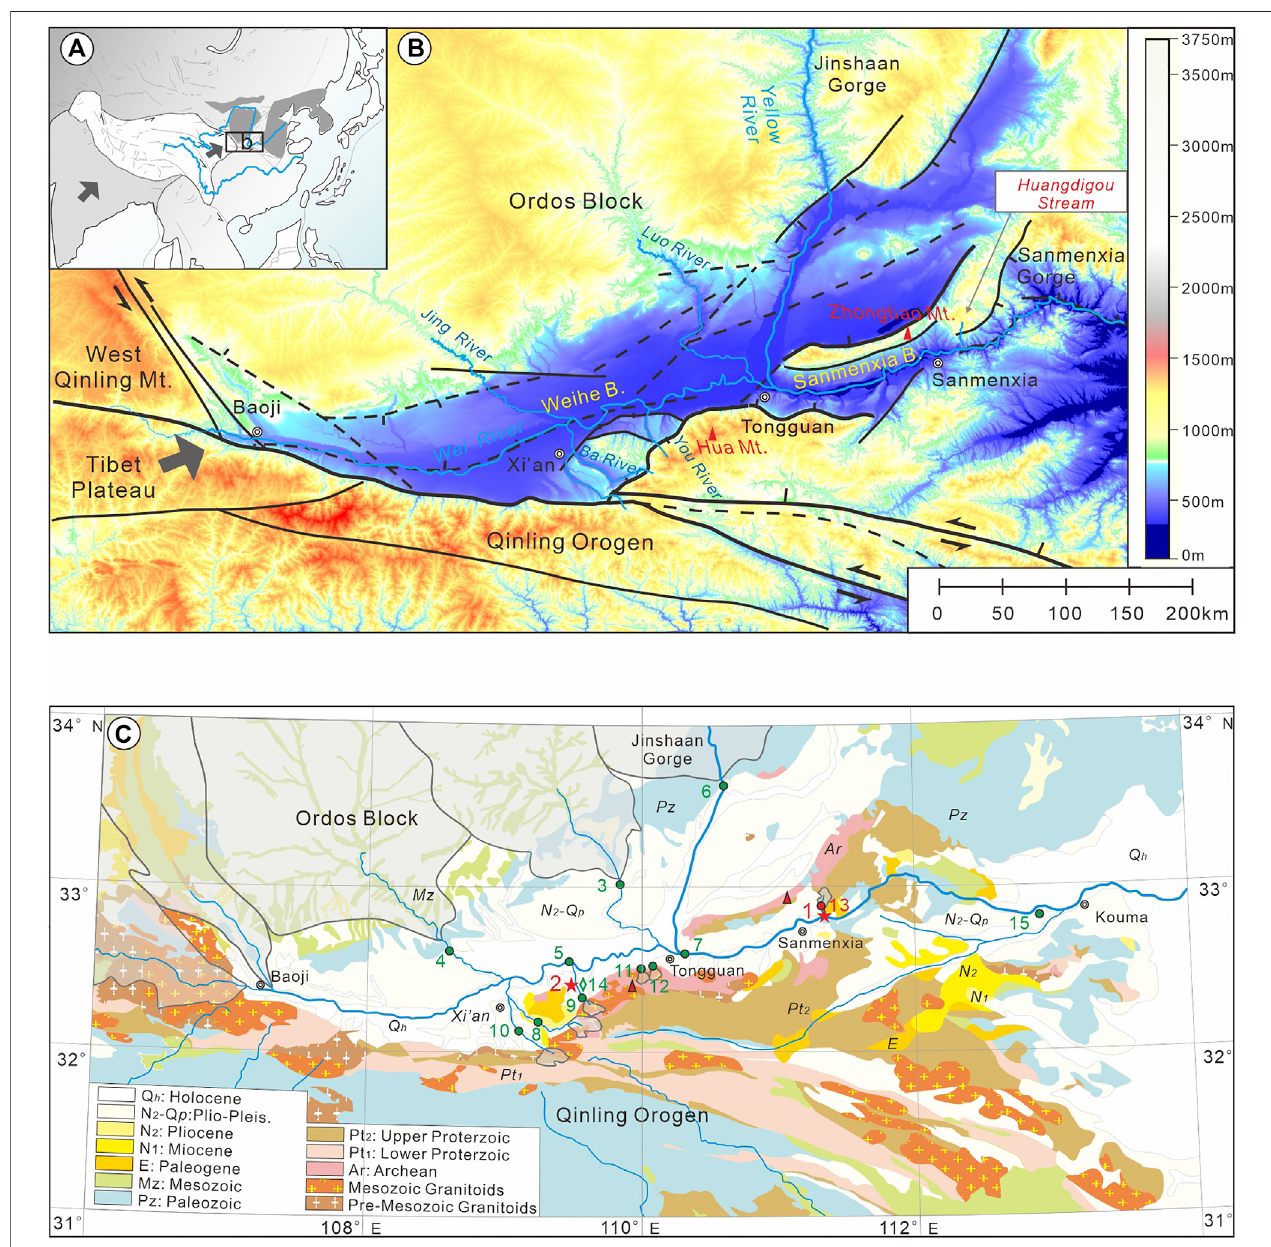
FIGURE 1 | (A) , Locating of the Yellow River and the study area. (B) , Tectonic setting and geomorphic features of the Weihe Basin and Sanmenxia Basin. (C) , Lithostratigraphy ofthe study areaand the sampling location. The stars indicate the study site in this article (1. Huangdigou section; 2. Songjiabeigou section). The open circlesandnumbersarethelocationsofpublishedmodernriversamples,andthediamondsindicatethelocationsofthesitesofpreviouslystudiedsamplesfrombasinor terrace sediments (see Supplementary Table S1 for sample information).